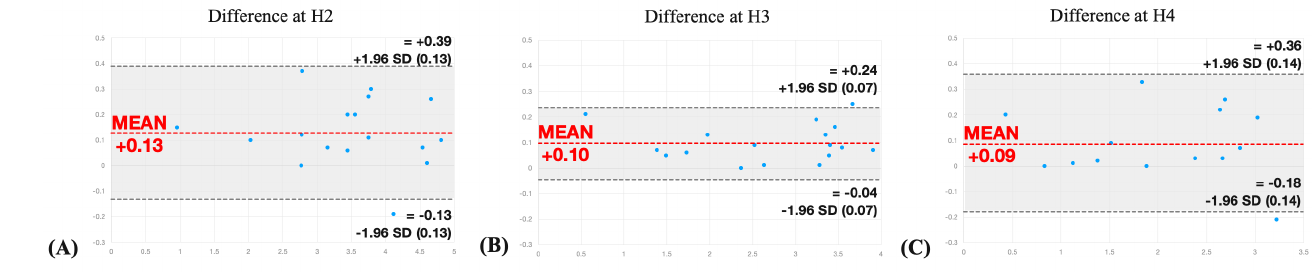
Figure 4. Bland − Altman plots. ( A ) At the 2-mm level, ( B ) At the 3-mm level, and ( C ) At the 4-mm level. H2: 2 mm below the ridge crest, H3: 3 mm below the ridge crest, H4: 4 mm below the ridge crest.